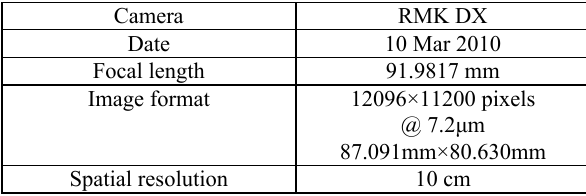
Table 1. Information Related to Test